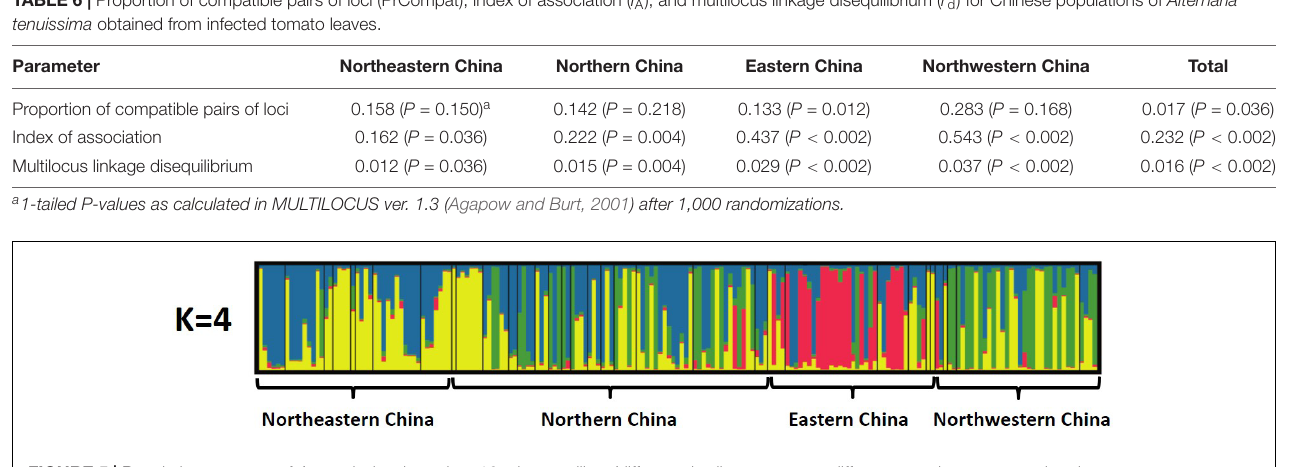
and within populations, respectively ( P < 0.001) ( Table 7